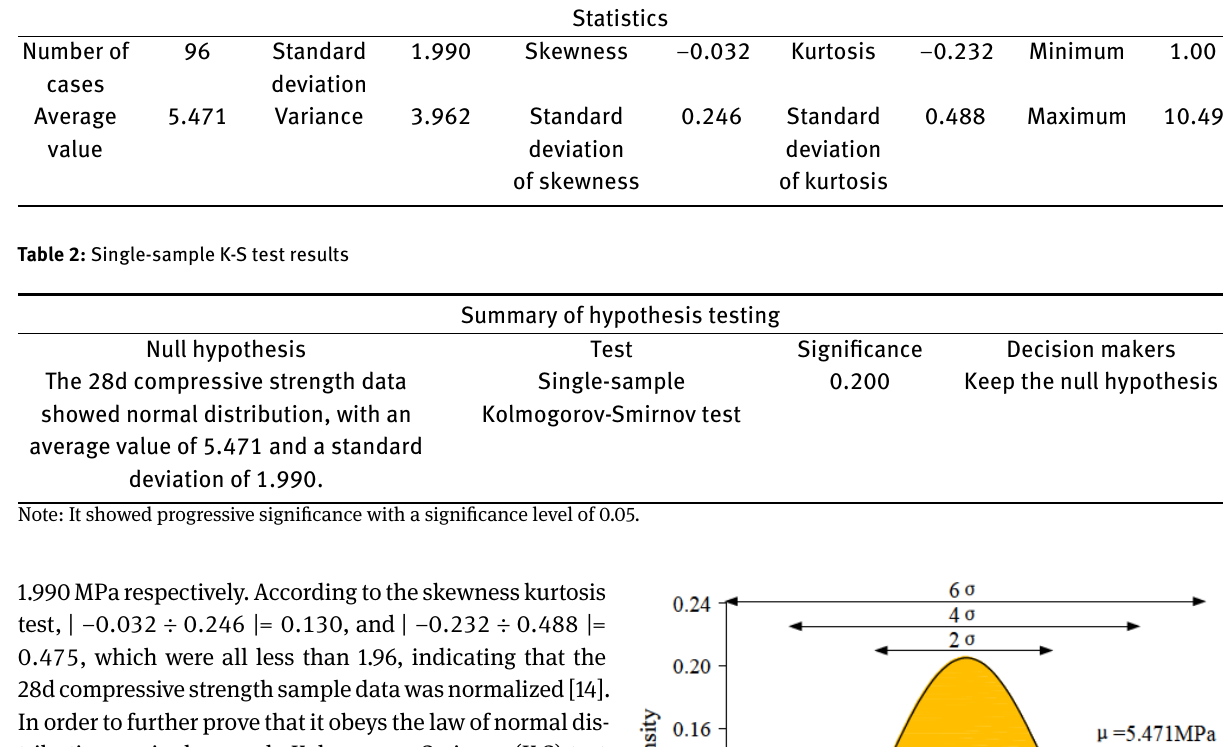
Table 1: Statistics of 28d compressive strength sample data